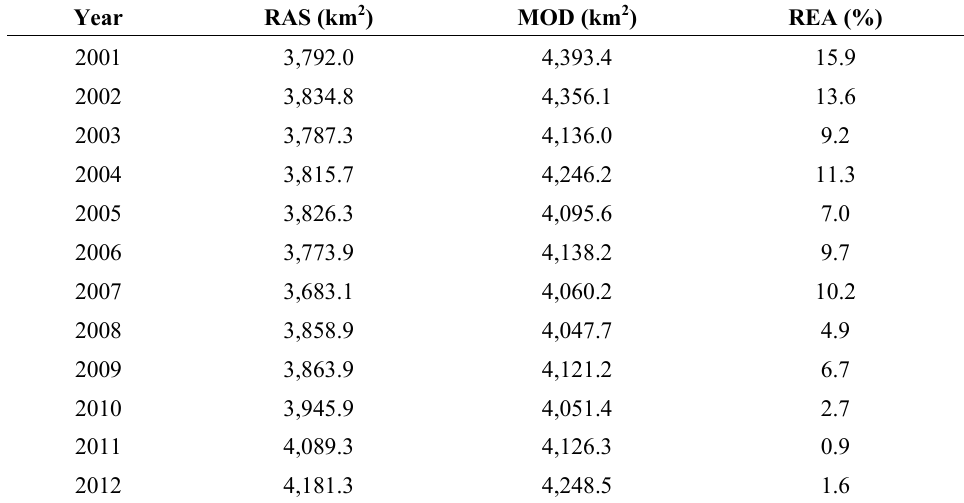
Table 2. The relative error in area (REA) between the MODIS-derived rice area and the rice area statistics, REA (MOD RAS) / RAS 100 = − × , where RAS = rice area statistics, MOD = MODIS-derived rice area. Year RAS (km 2 ) MOD (km 2 ) REA